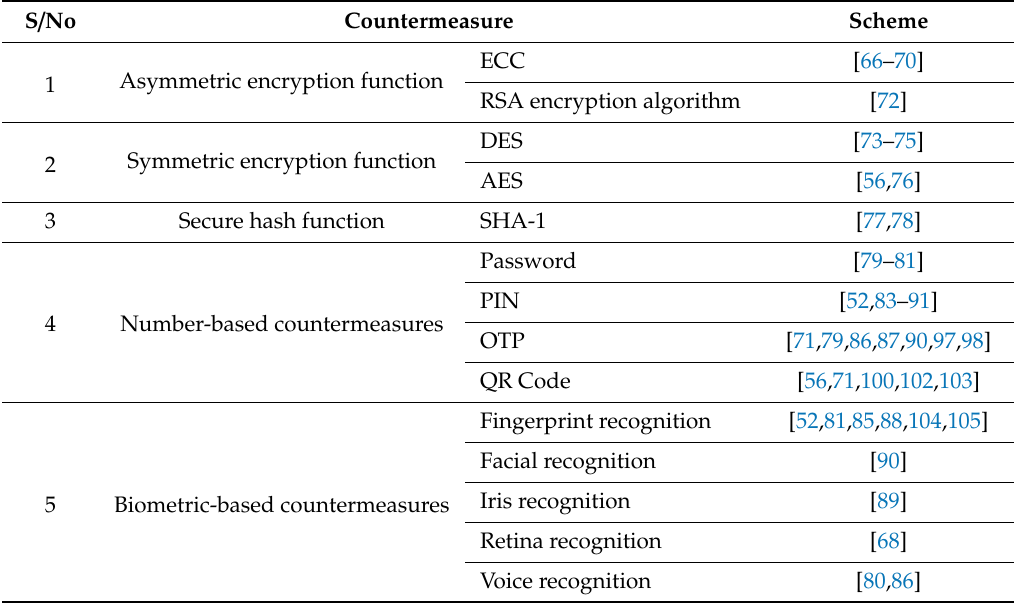
Table 1. Summary of the countermeasures against the attacks in mobile money authentication schemes. S /